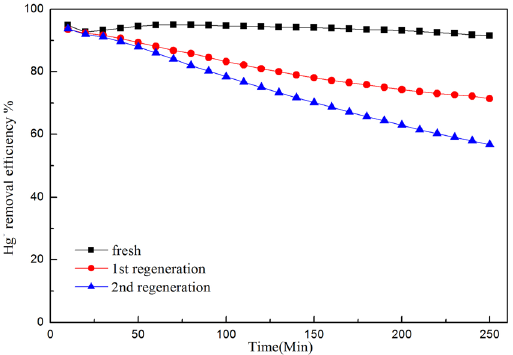
Figure 4. Efficiencies of Hg 0 removal over Fe 3 O 4 -NH 2 -Pd along with two regeneration cycles.